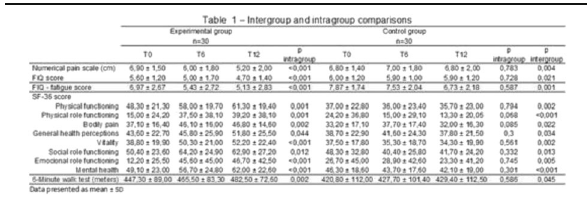
Table 1 (abstract O37). Intergroup and intragroup